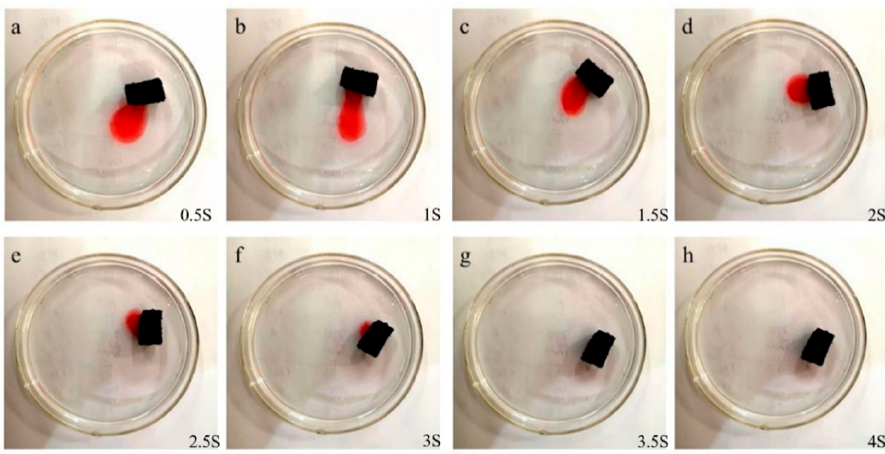
Figure 8. The test chart of the adsorption performance of PDMS modified graphene oxide aerogel on oil red-dyed n-hexane. ( a – h ) is a photo taken every 0.5 s of